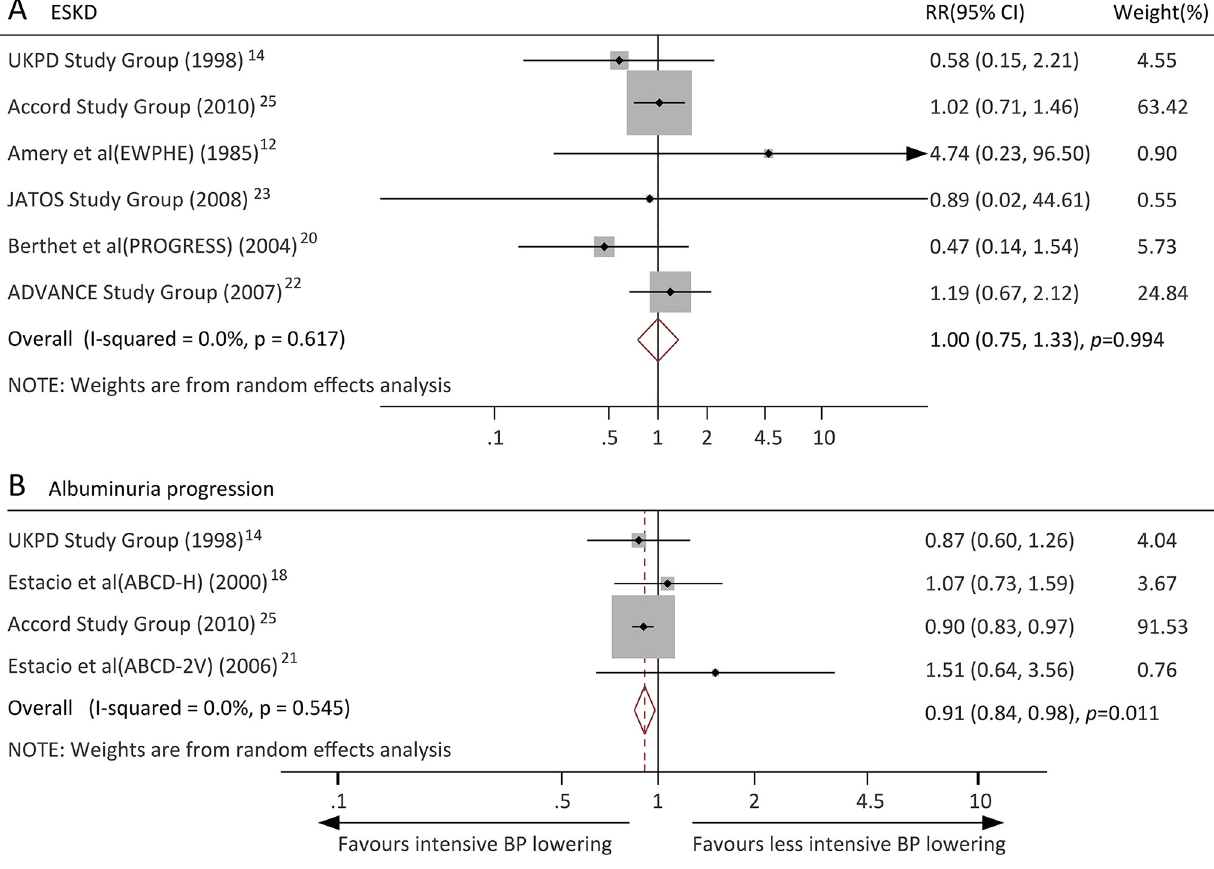
Fig 5. Effects of intensive blood pressure lowering on risk of renal outcomes (A) End stage kidney disease; (B) Albuminuria progression.